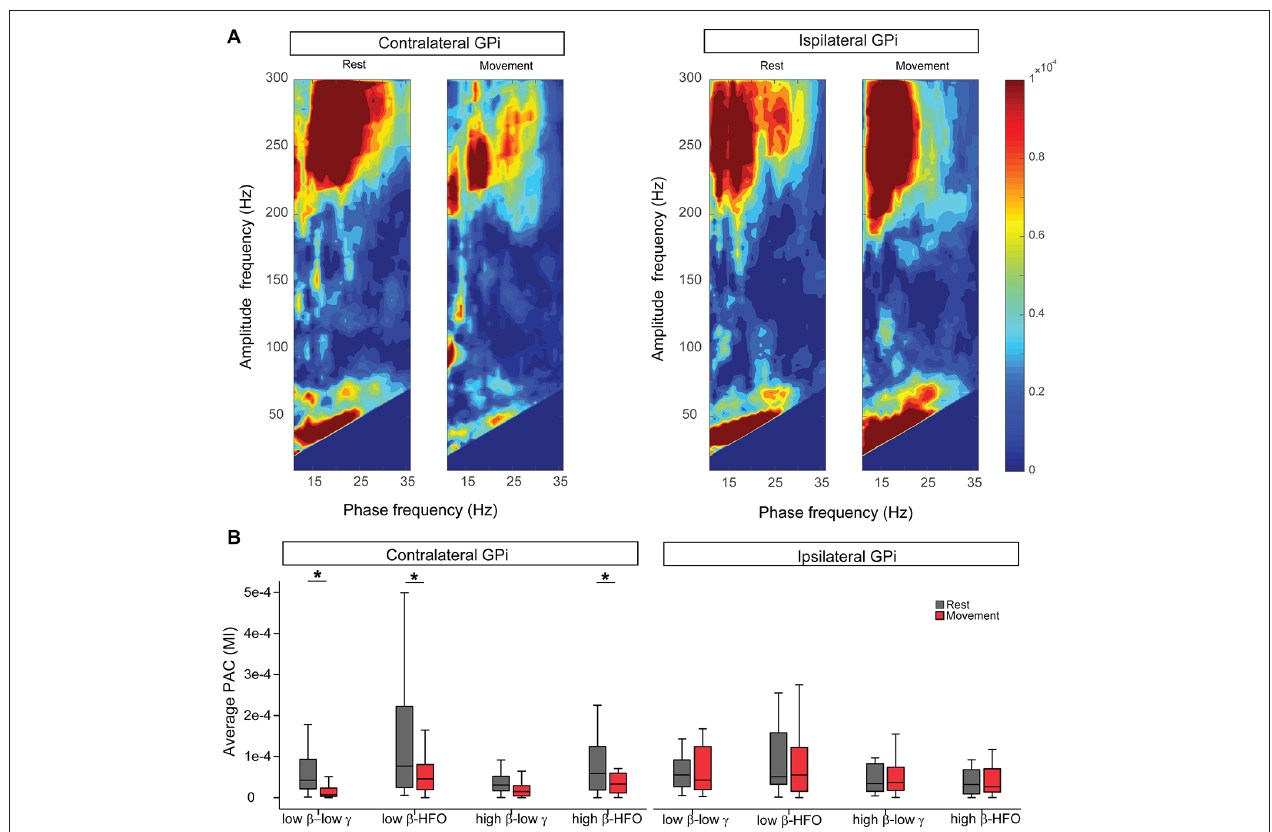
FIGURE 2 | Unilateral hand movement modulates phase-amplitude coupling (PAC) only at the GPi contralateral to the moving body side. (A) Average comodulogram (MI values) for the cohort at bilateral GPi during rest and movement conditions. (B) Comparison of average PAC values at different frequency bands during rest (gray) and movement (red) indicates significant suppression of the PAC only at the GPi contralateral to the movement side. Asterisk signs ( ∗ ) indicate statistical significance of the difference between the two conditions as tested by Wilcoxon signed-rank test and corrected for multiple comparisons ( P < 0.05). Each box contains the interquartile range and whiskers extend to the highest and lowest